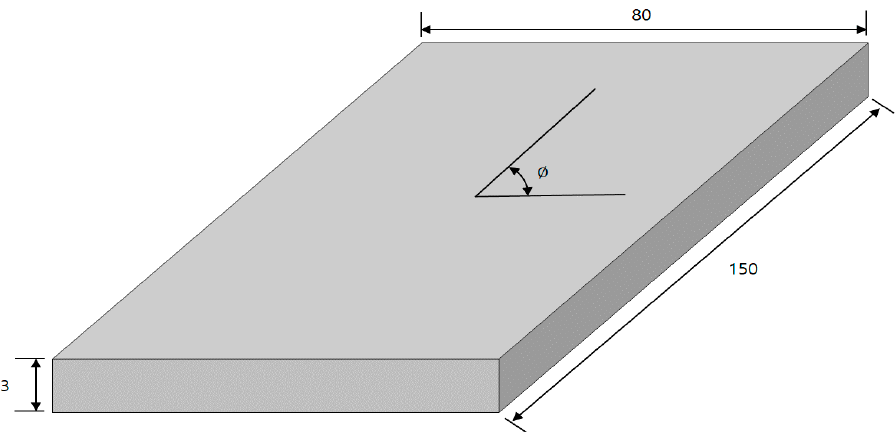
Figure 2. Configuration of five carbon-fiber-reinforced plastic material (CFRP) specimen (unit: mm) under di ff erent direction of carbon fiber: φ = 0, 30, 45, 60, and 90 degrees.